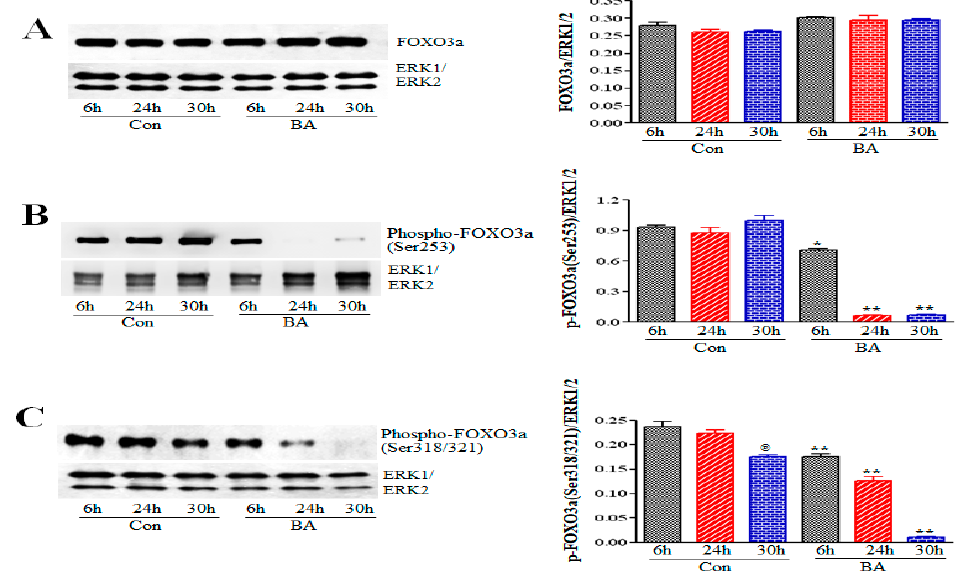
Figure 6. Assessment of butyrate e ff ect on FOXO3. Cell lysates prepared from VSMCs treated with (BA) or without (Con) butyrate for indicated periods were subjected to Western blot analysis. ( A ) Analysis of total FOXO3 by immunoblotting with antibody specific to FOXO3. ( B ) Phosphorylation of FOXO3 at Ser253.* p < 0.01 vs 6 h control (Con); ** p < 0.001 vs respective control (Con). ( C ) Phosphorylation of FOXO3 at Ser318 / 321. (cid:173) p < 0.01 vs 6 h control (Con); ** p < 0.001 vs respective control (Con).